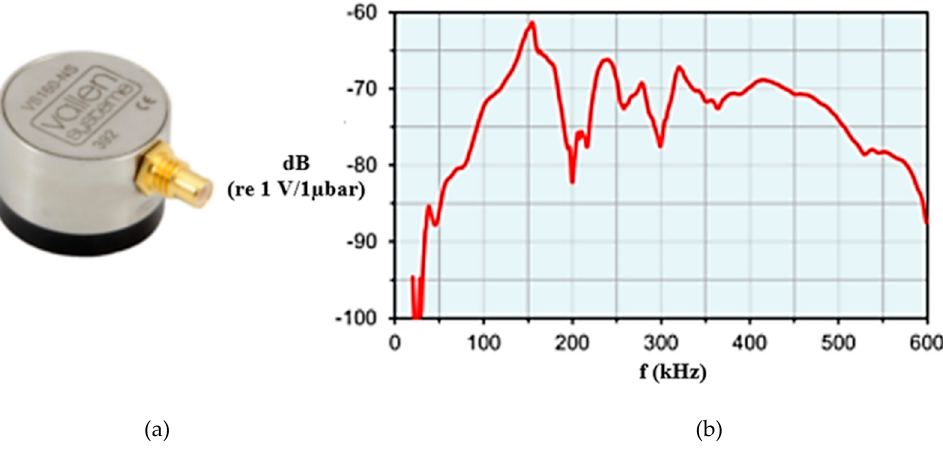
Figure 9. ( a ) VS-160 AE sensor. ( b ) Frequency sensitivity spectrum of the VS-160 AE Figure 9. (a) VS-160 AE sensor. (b) Frequency sensitivity spectrum of the VS-160 AE sensor.